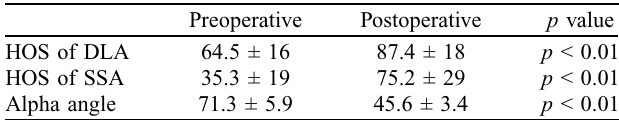
Table 2. Comparison between preoperative and postoperative values (mean ± SD ) of functional scores and alpha